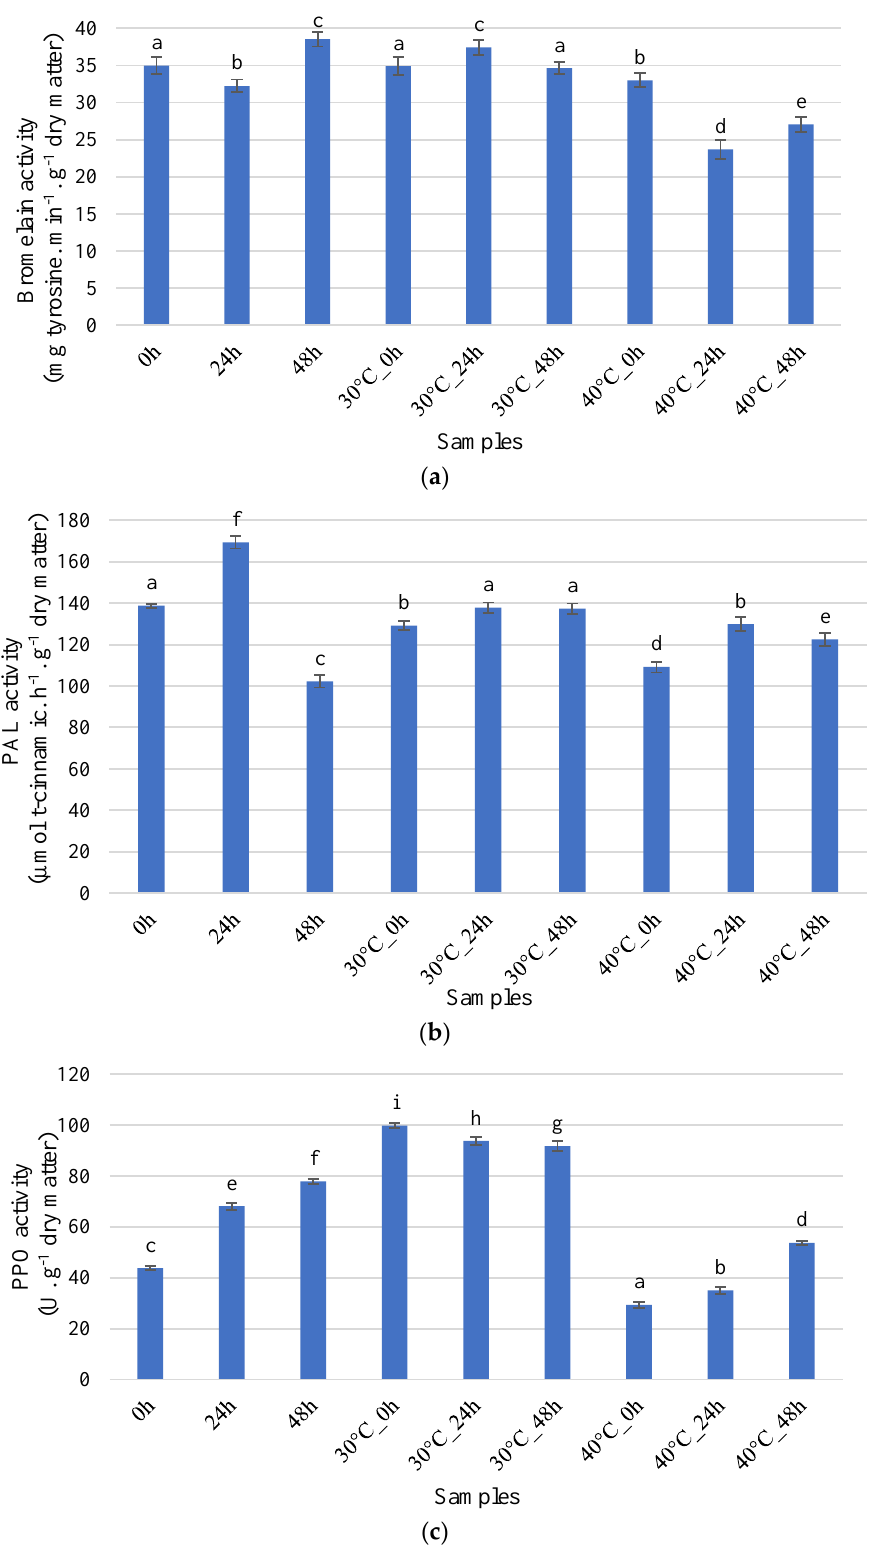
Figure 5. Effect of heat treatment, on the enzymatic activity of pineapple shell: ( a ) bromelain activity; ( b ) phenylalanine ammonia-lyase activity (PAL); and ( c ) polyphenol oxidase activity (PPO). Error bars stand for ± standard deviation ( n = 9). Different letters express significant differences between samples.